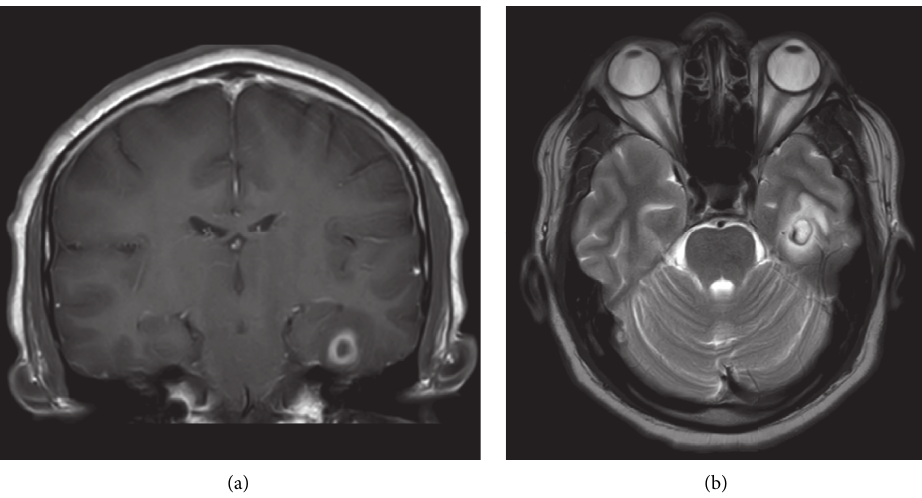
Figure 1: Magnetic resonance images of the left temporal lobe lesion. (a) Contrast-enhanced coronal T1-weighted image, showing rim- enhancing left temporal lobe lesion. (b) Axial T2-weighted image showing the same lesion with mild surrounding vasogenic